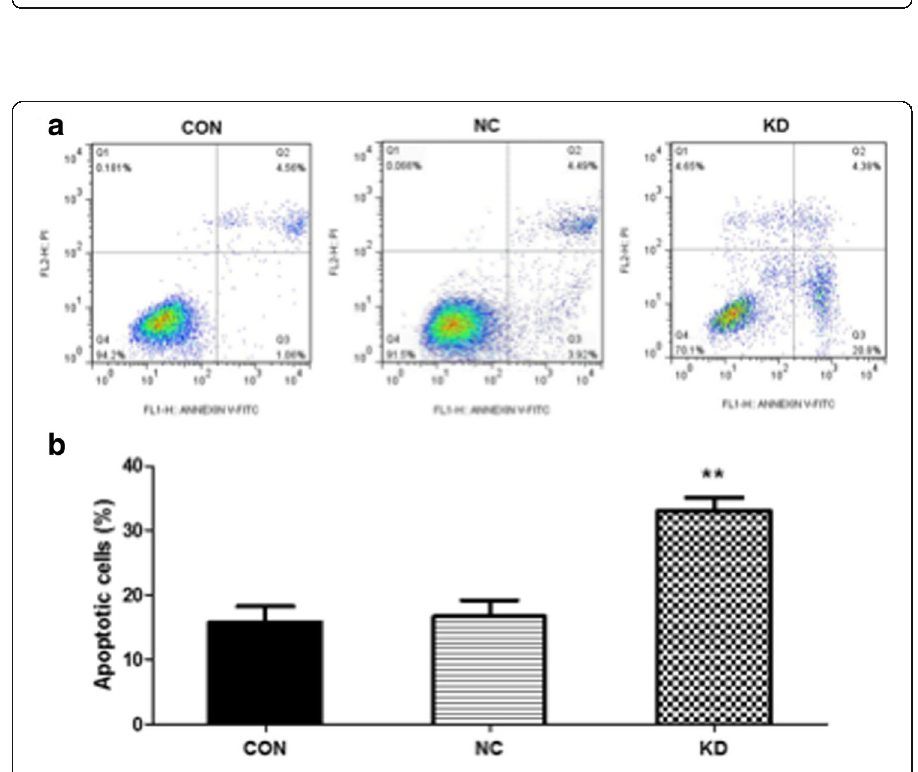
Fig. 3 Knockdown of SNHG8 induced the apoptosis of GT38 cells. a Flow cytometric analysis for cell apoptosis in GT38 cells transfected with (KD group) or without the specific shRNA (NC group). b The corresponding statistical results. ** p < 0.01 compared with NC group. CON, blank control cells without transfection; NC, negative control; KD, SNHG8